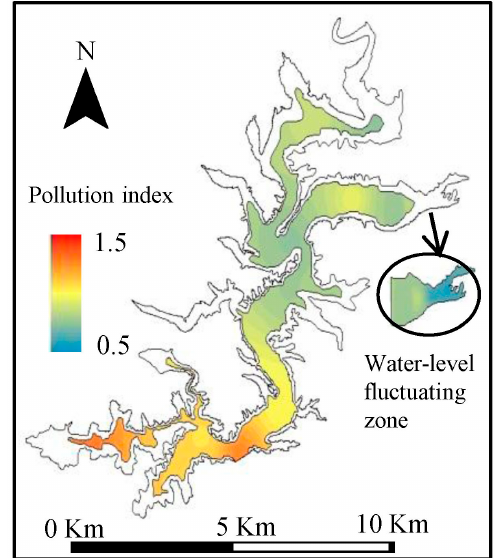
Figure 6. The ecological risk of sediment P pollution.